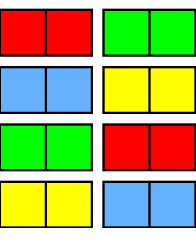
Figure 12. A grid of 4 × 4 cells partitioned into horizontal pairs of cells.